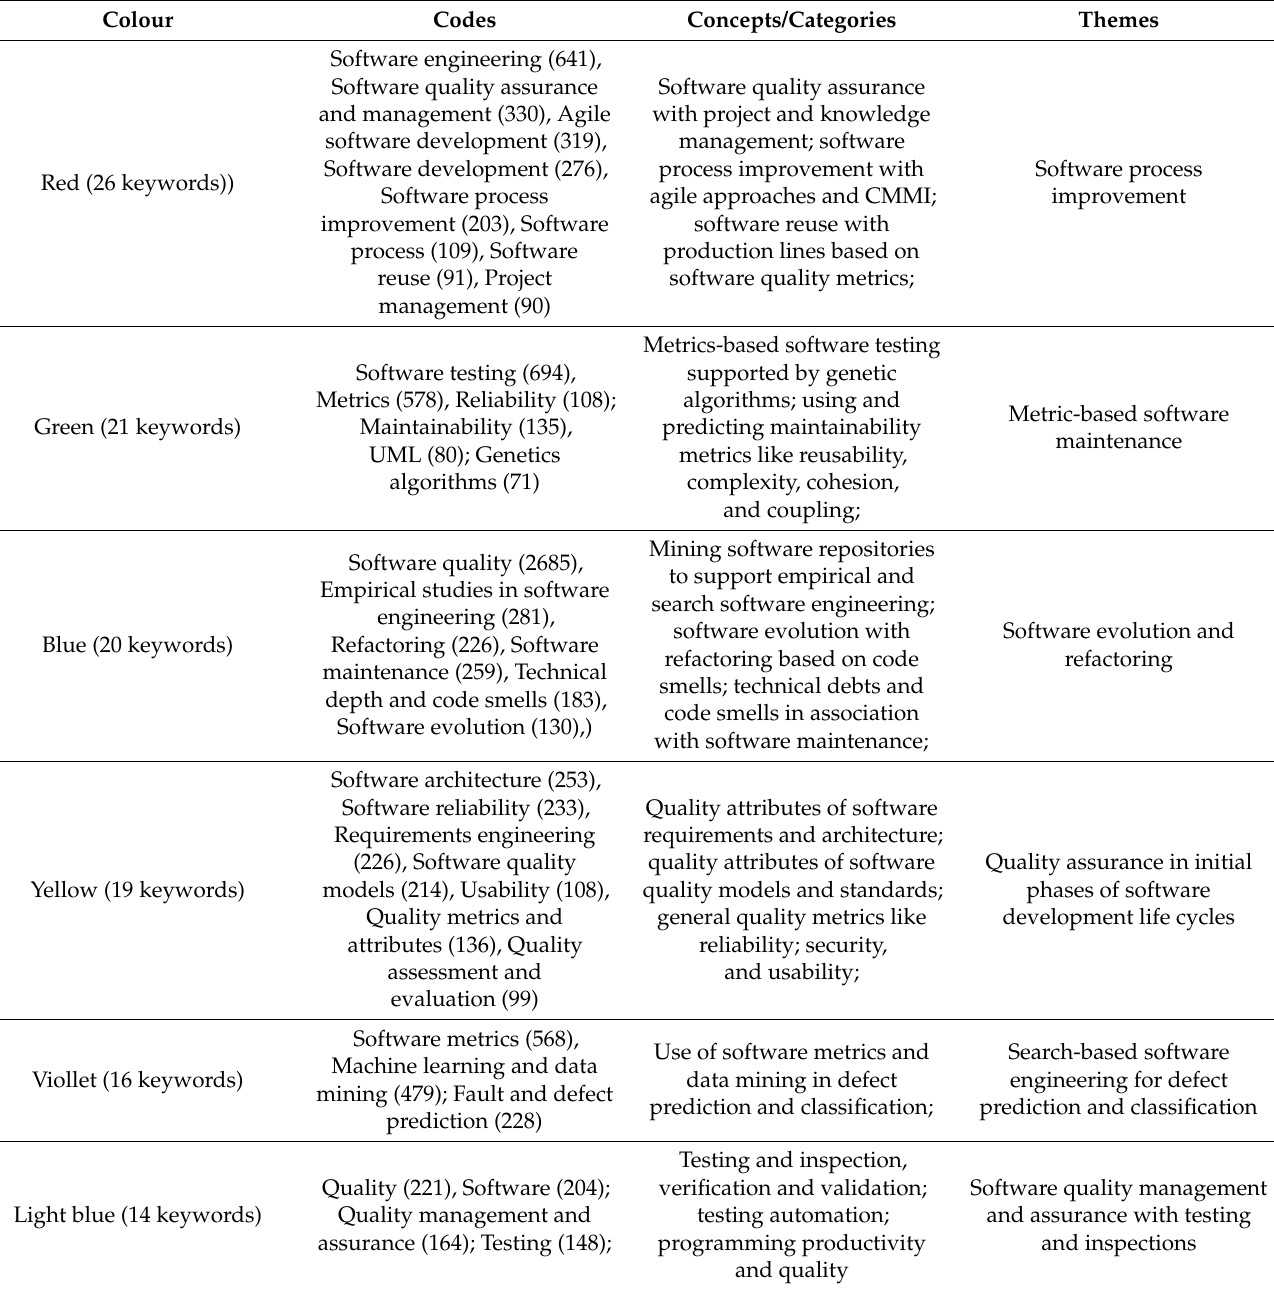
Table 5. Software quality research themes (numbers in parenthesis present the number of publications in which an author keyword